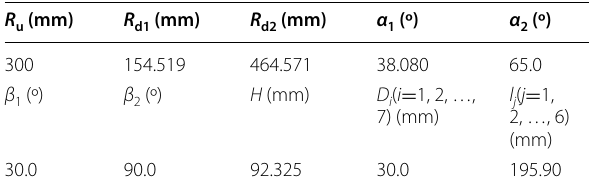
Table 1 Structural parameters of 7-SS passive overconstrained structure